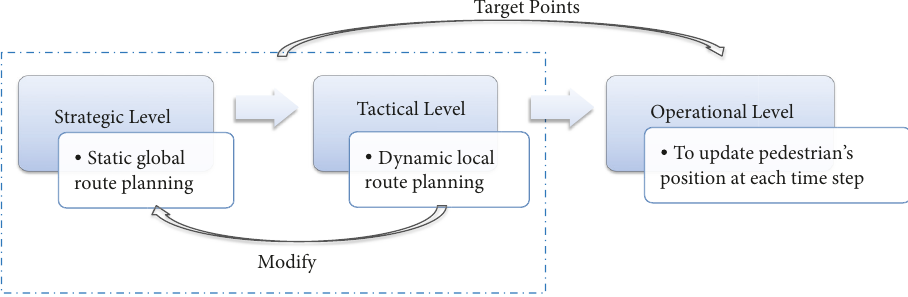
Figure 1: The three levels of navigation